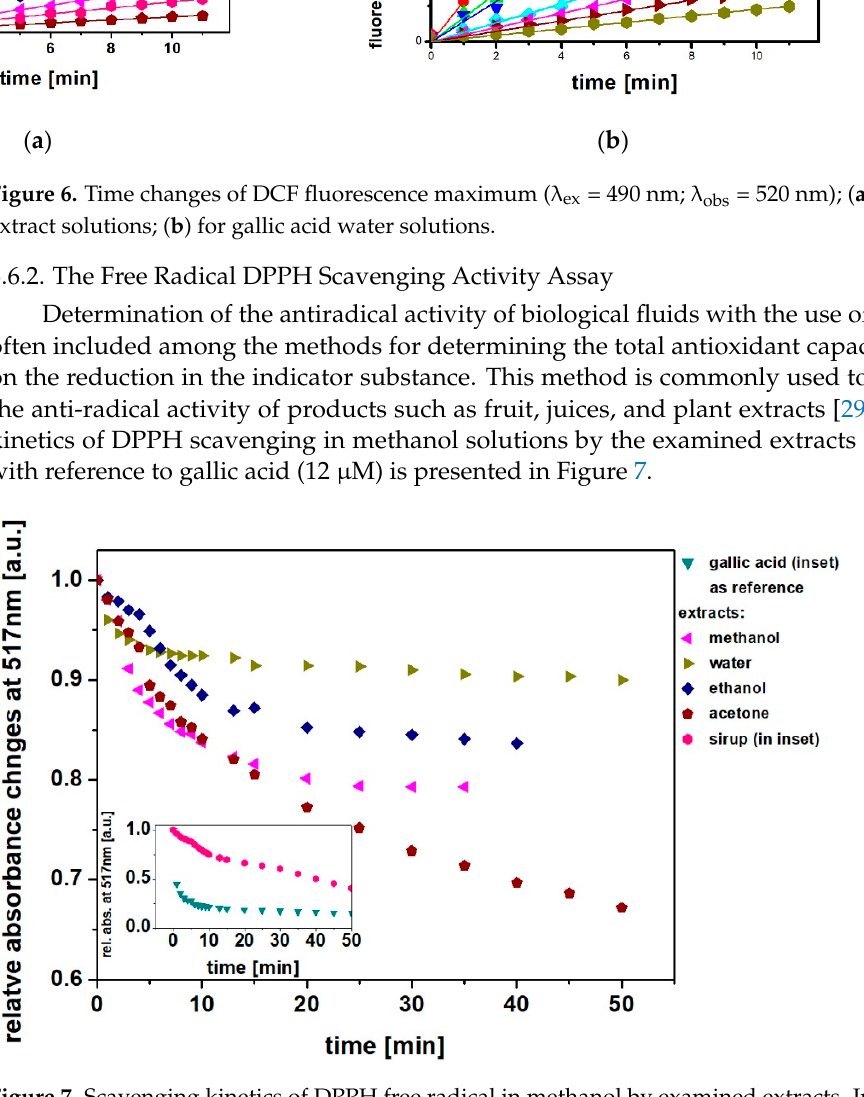
Figure 8. Maximum scavenging of DPPH free radical by extract examined. 3.6.3. Oxidation in Liposomes The oxidation process of the lipids was measured with the C11-BODIPY581/591 probe used as a fluorescent indicator. C11-BODIPY581/591 has been commonly used to determine lipid peroxidation in liposomes and mammalian cells [13,33]. The time changes of maximum fluorescence intensity of the C11-BODIPY581/591 probe embedded in the PC membrane is presented in Figure 9. The figure reveals the thermal autooxidation of